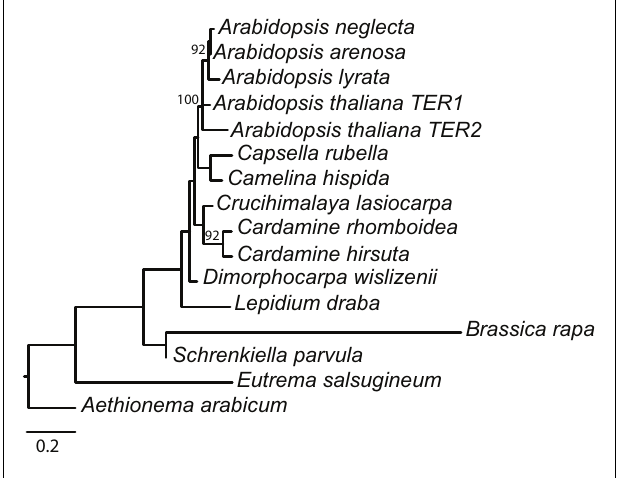
FIGURE 2 | Phylogeny of 330 nt alignment ofArabidopsisTER1 and TER2 with putativeTER loci from 14 other Brassicaceae species. Values above nodes are from 100 likelihood bootstrap replicates, only values above 60% are reported. Scale bar is 0.2 substitutions/per site.